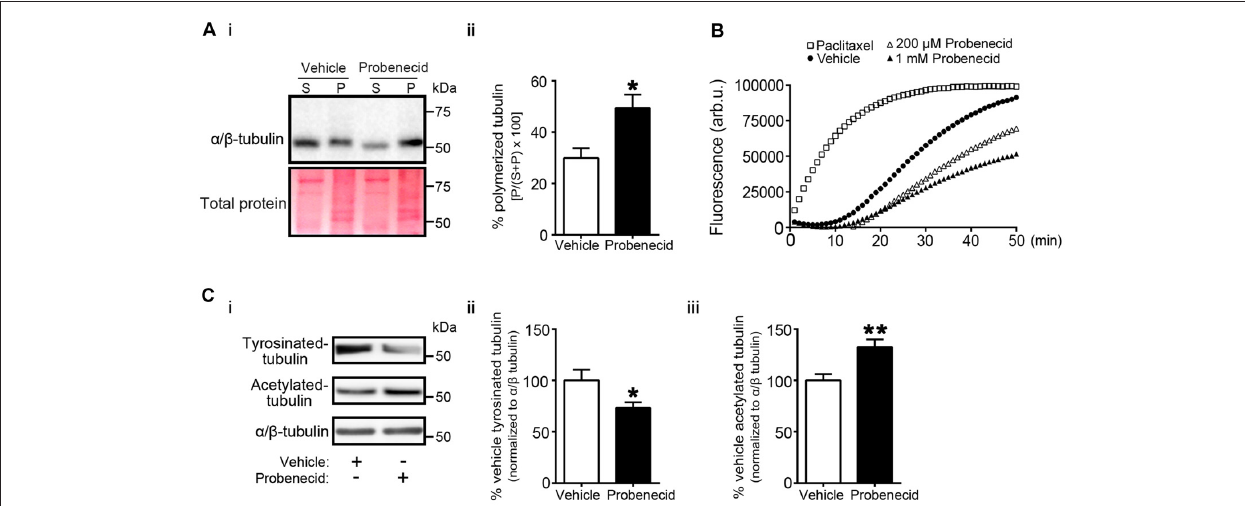
FIGURE 6 | Probenecid treatment increases microtubule stability in cells. (Ai) N2a cells were treated with vehicle control or probenecid and then fractionated to obtain polymerized and soluble microtubule fractions. P (pellet) contains the polymerized microtubule fraction and S (supernatant) contains the soluble tubulin fraction. Ponceau S staining was employed as a loading control. (ii) Probenecid enhanced the percentage of polymerized microtubules to soluble tubulin (vehicle: 29.9 ± 3.8% vs. probenecid: 49.4 ± 5.2%, p = 0.0107 by unpaired t -test; n = 7). (B) Tubulin polymerization assays in vitro . Paclitaxel (3 µ M) and vehicle were employed as positive and negative controls, respectively. The experiment was performed three times, with the replicates as follows: paclitaxel n = 5; Vehicle n = 5; 200 µ M Probenecid n = 5; 1 mM Probenecid n = 7. (Ci) Western blot of post-translationally modified tubulin species from N2a cells treated with probenecid or vehicle control. Tyrosinated-tubulin represents the dynamic population, and acetylated-tubulin represents the stable population. Total α / β -tubulin was used for normalization. Probenecid treatment (ii) decreased tyrosinated-tubulin (100.0 ± 10.5% vs. 73.3 ± 5.5%, p = 0.0377 by unpaired t -test; n = 9) and (iii) increased